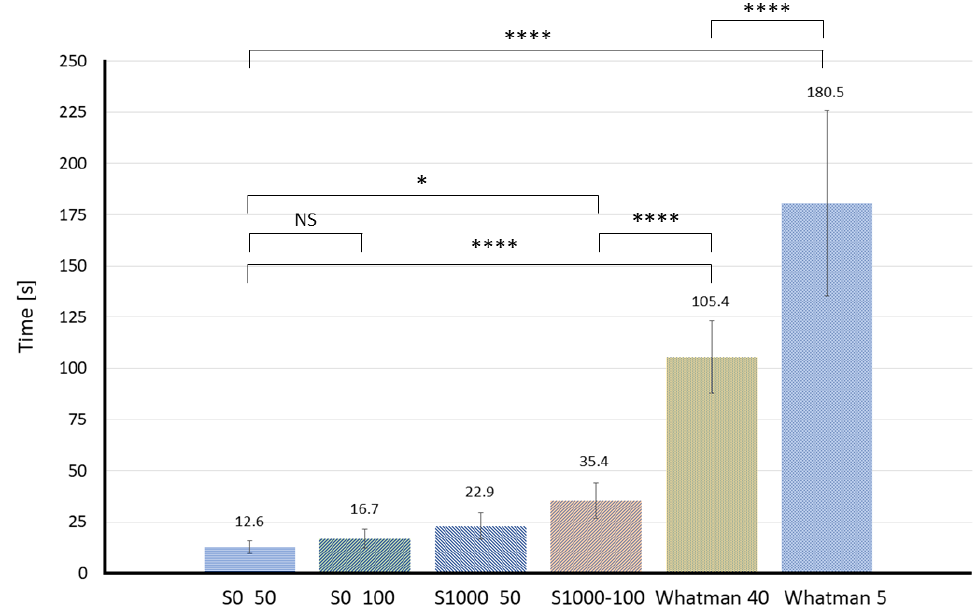
Figure 6. Required time for each different paper substrate to achieve a 1.0 mm diffusion width at the measurement line. The asterisk (*) represents the p -value of the statistical test. (* p < 0.05, **** p < 0.0001, NS: non-significance).